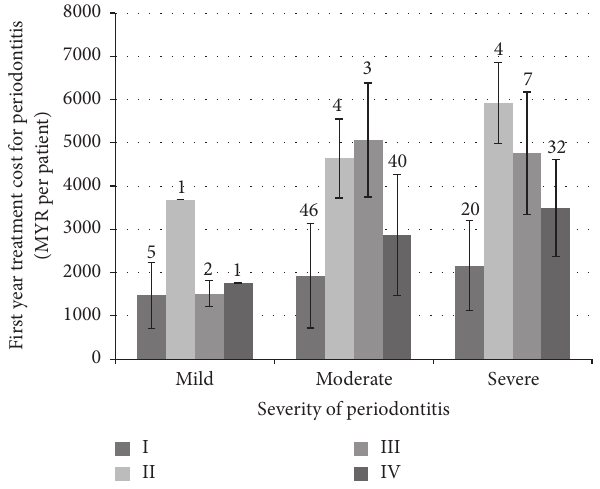
Figure 2: Average treatment cost for periodontitis by treatment mix and periodontitis severity (Total patients = 165). I: nonsurgical only (NSPT), II: NSPT and periodontal surgery (PS), III: NSPT and nonsurgical rehabilitative therapy (NSRT), IV: NSPT, PS, and